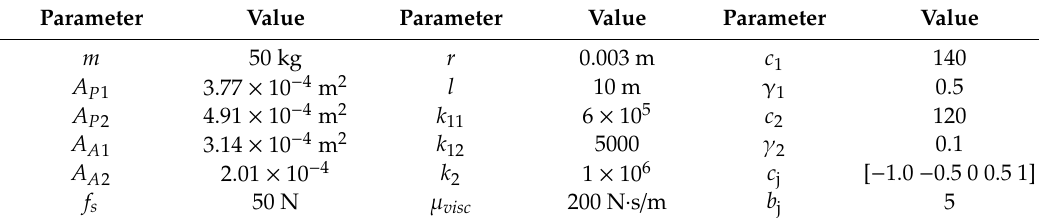
Table 1. The servo system’s parameters.